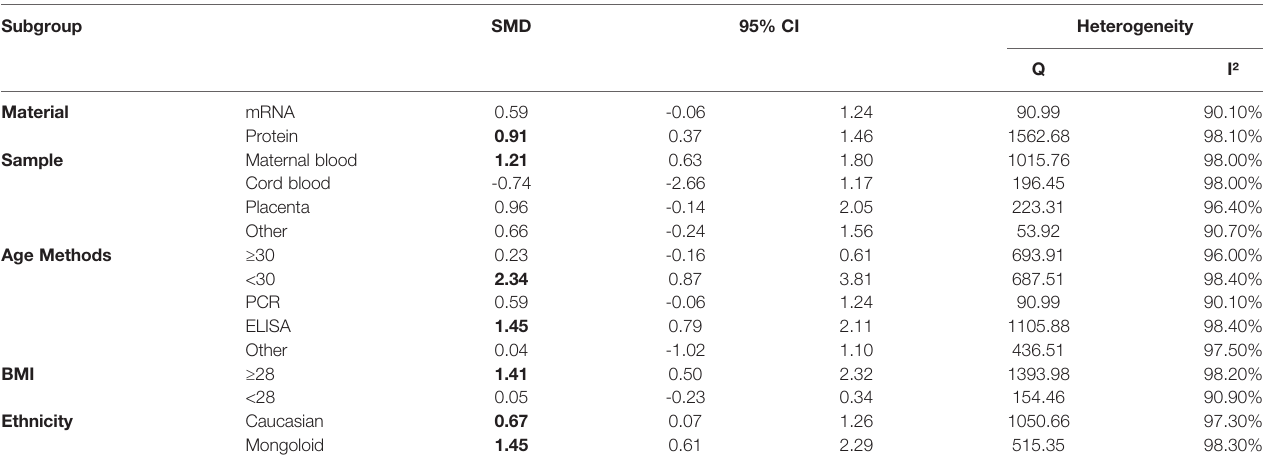
TABLE 2 | Subgroup analysis of chemokine between GDM participants and controls. Subgroup SMD 95% CI